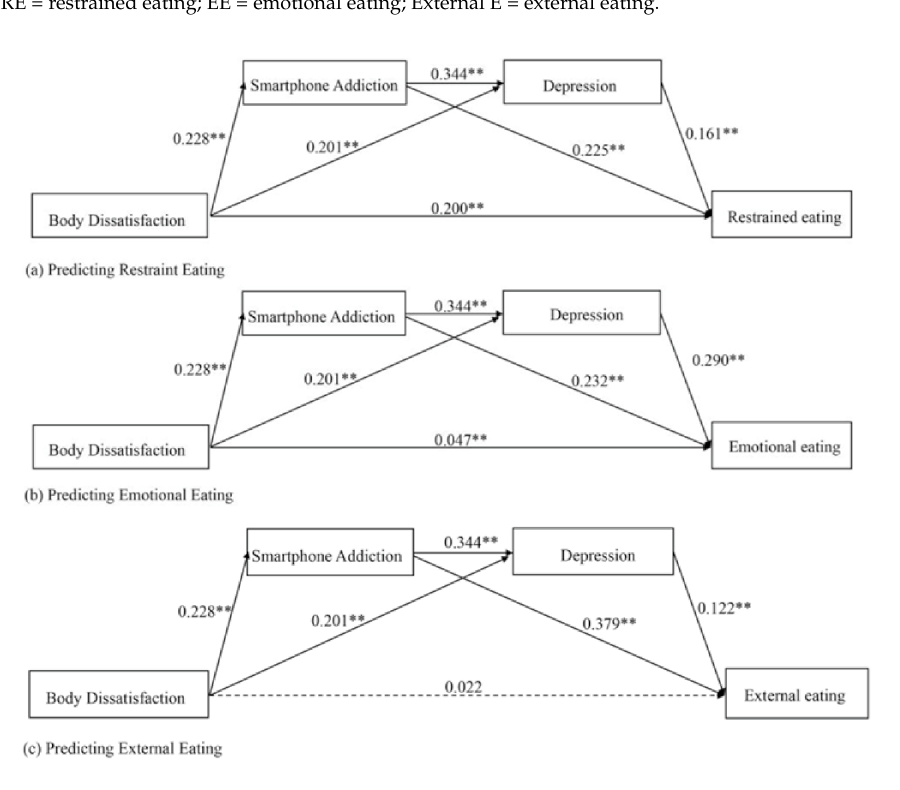
Figure 1. Multiple mediation models predicting ( a ) restrained eating, ( b ) emotional eating and ( c ) external eating from body dissatisfaction, smartphone addiction and depression. All path coeffi- cients are standardized. ** p <